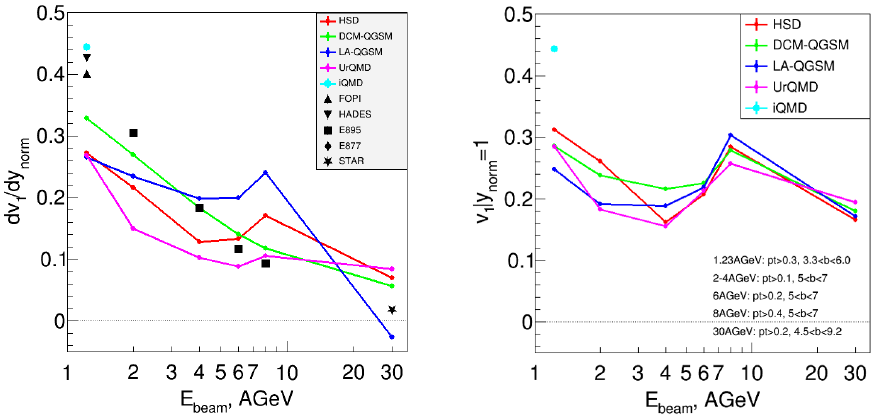
Figure 2. Integrated particle flow vs beam energy around midrapidity (left) and projectile rapid- ity (right). Simulations are done by means of di ff erent collision models for proton directed flow at Au + Au collisions at semi-centrality with b and p T cuts corresponding to indicated experimental